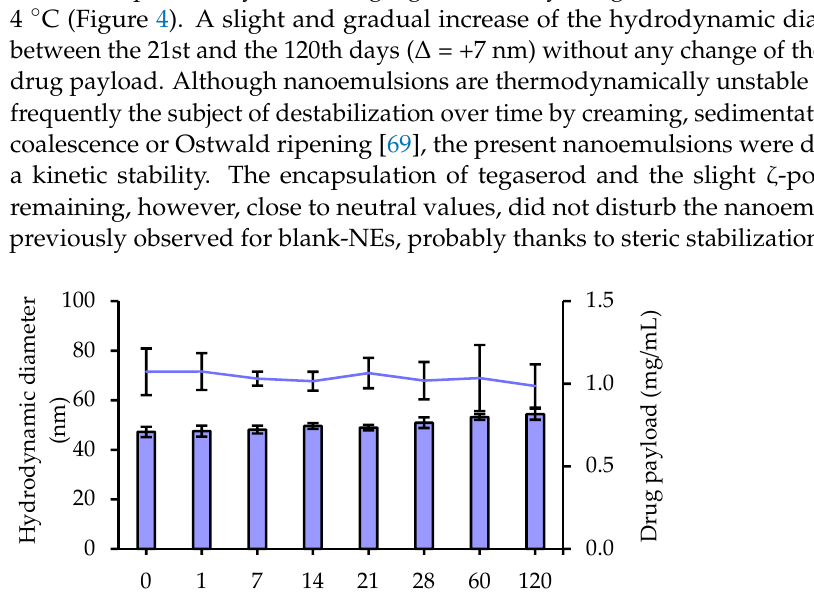
Table 4. Physicochemical characteristics of nanoemulsions ( n ≥ 18).